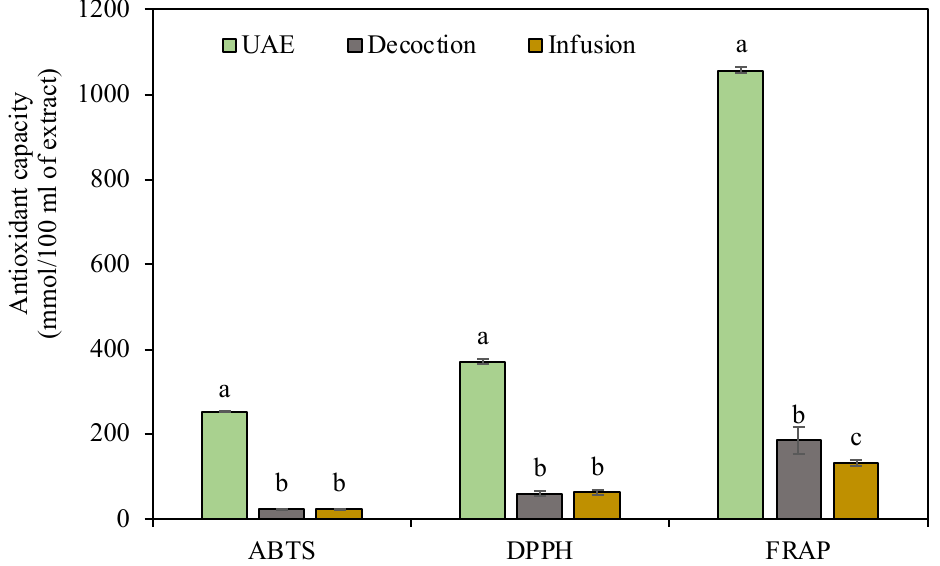
Figure 3. Antioxidant capacity of extracts obtained by the optimal conditions of ultrasound-assisted extraction (UAE), decoction, and infusion. Different letters indicate significant statistical differences between treatments using the LSD test with α = 0.05.